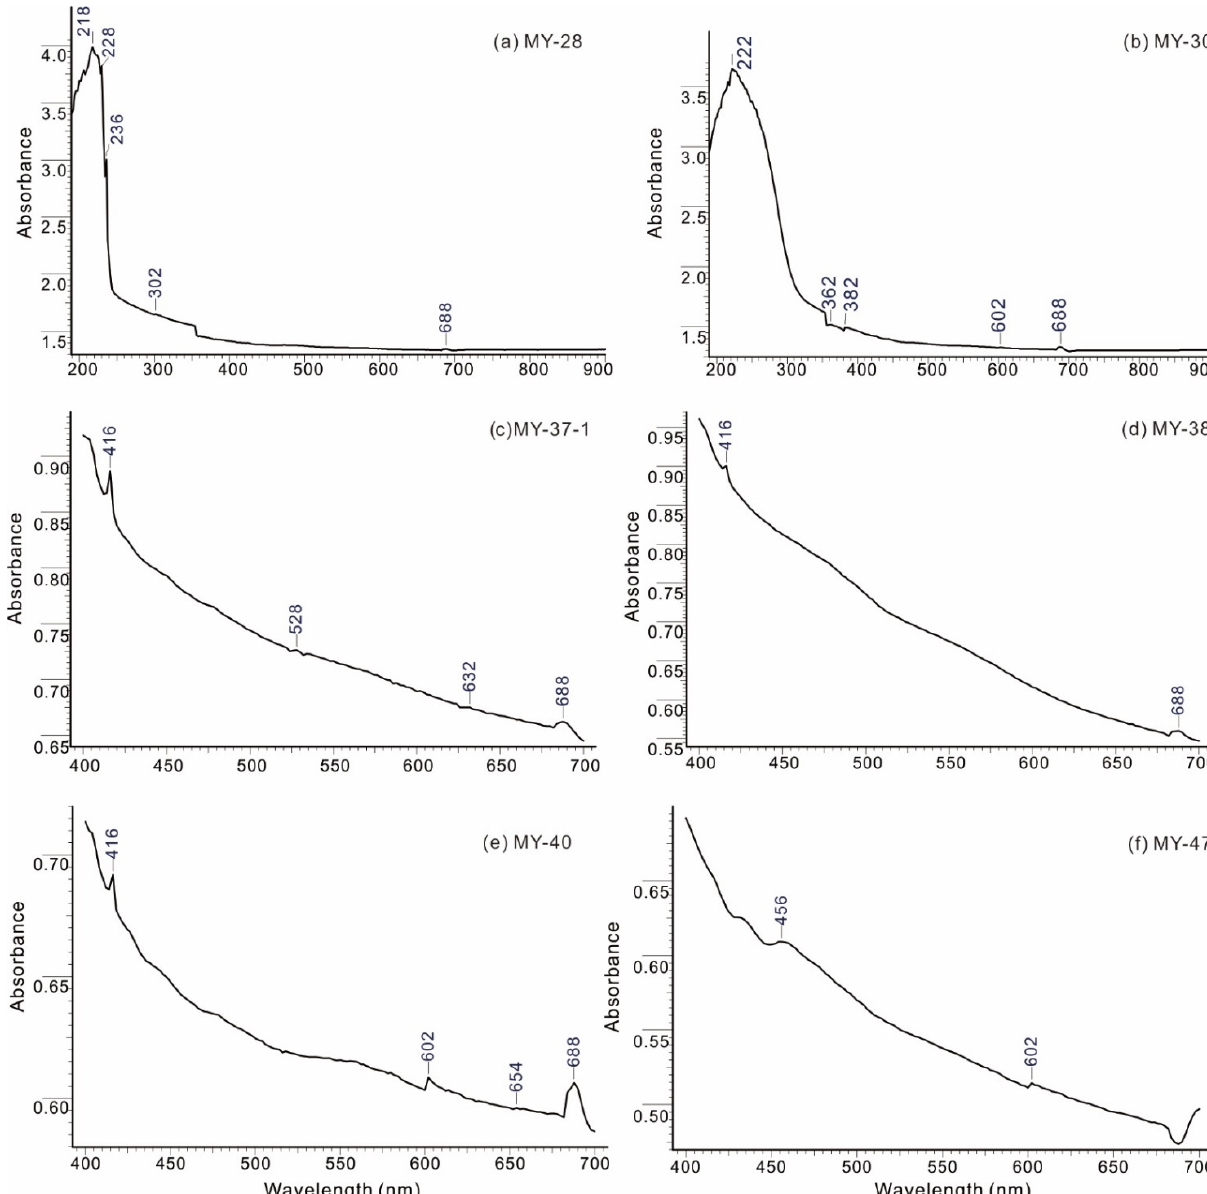
Figure 7. Ultraviolet-visible absorption spectrum diagrams of representative brown diamonds from the Mengyin deposit.